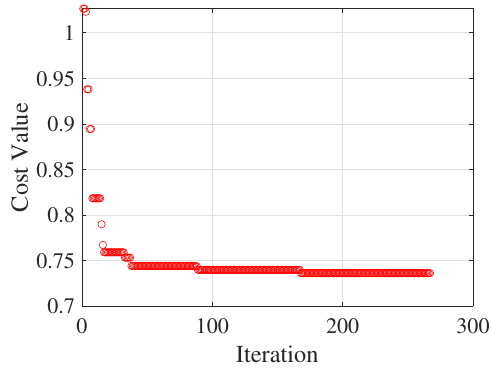
Figure 6. The best values of cost function in case